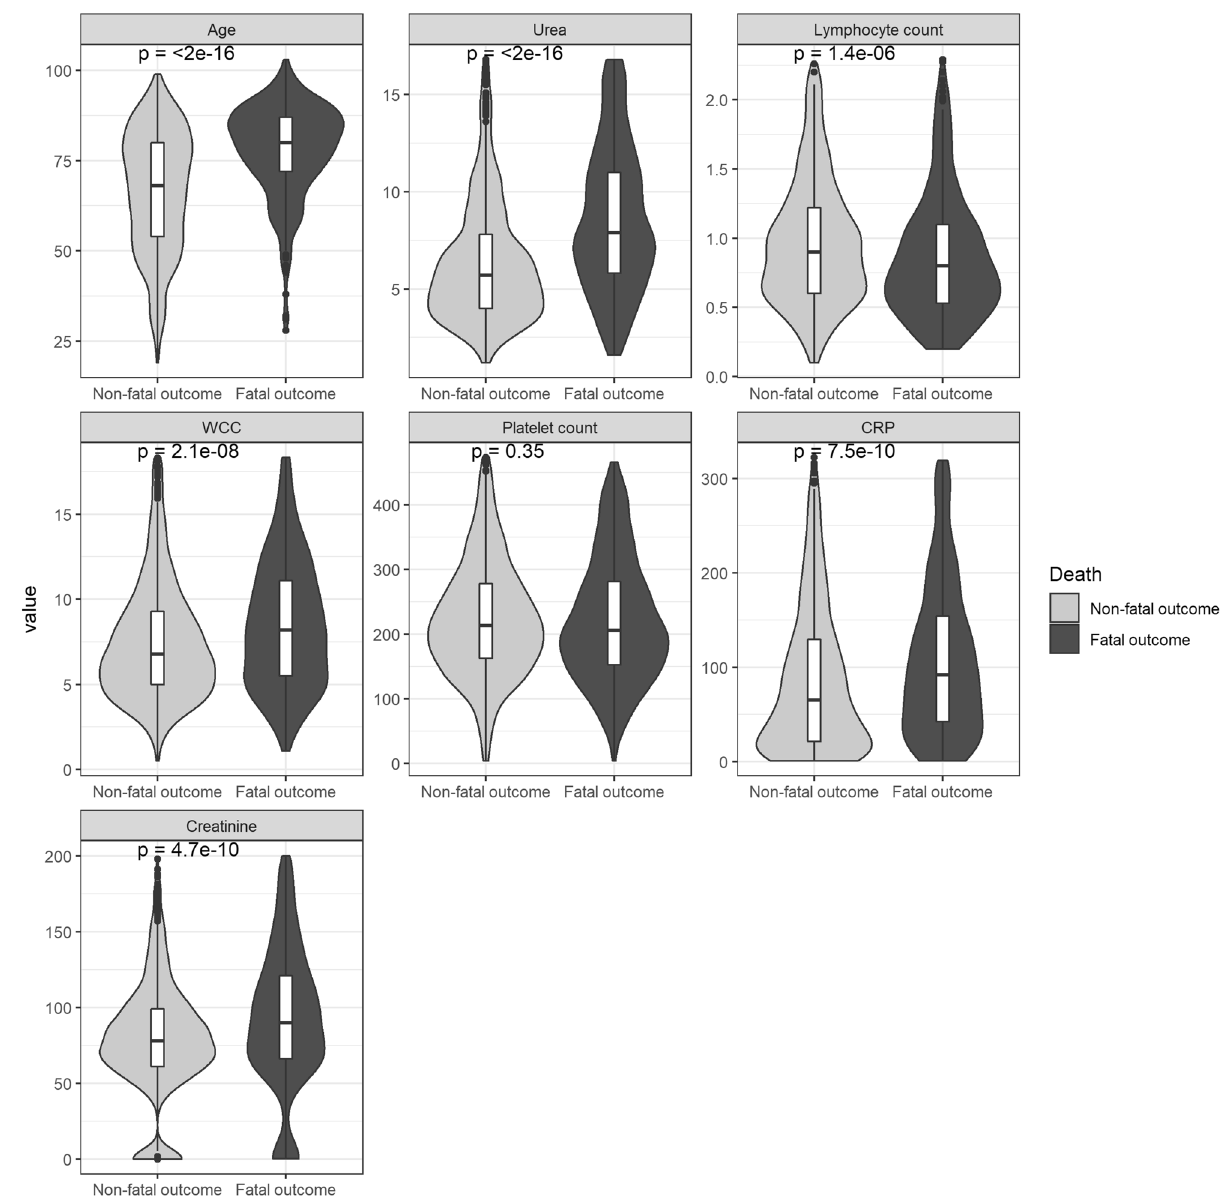
Figure 4. Violin plots of individual blood variables parameters and age, categorised by patient outcome. The boxplots showing median and 1st and 3rd quartiles of the predictor variables are overlayed on the violin plots. All NCCID patients tested positive by the RT-PCR test for SARS-CoV-2. WCC, white blood count; CRP, C-reactive protein. The p -values are tests of equality of population using the Wilcoxon rank-sum test, where p < 0.05 implies statistically significant difference between the